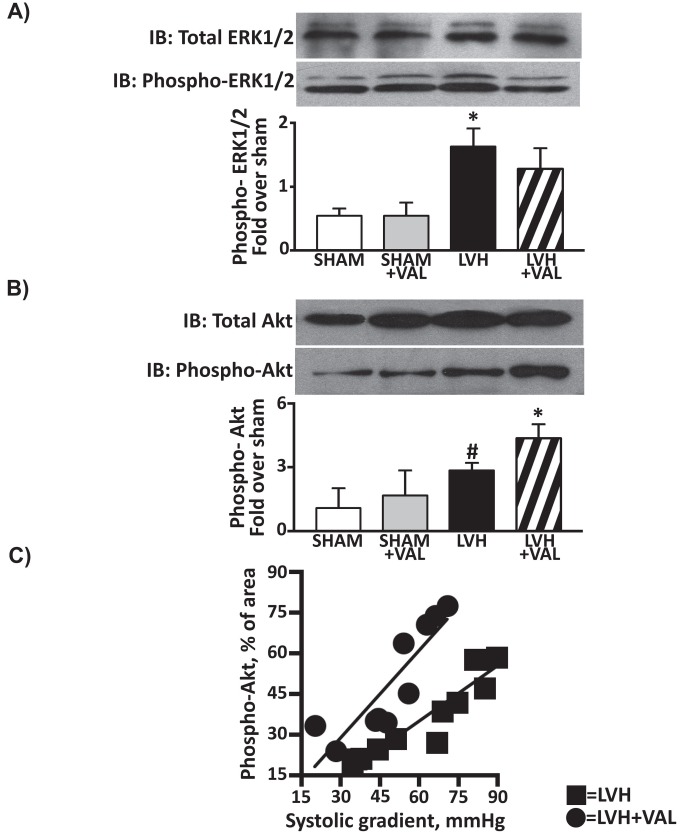
The maladaptive and detrimental molecular activation in hypertrophic hearts is attenuated by AT1R blockade.
A: Increased phosphorylation of MAPK-ERK1/2 was observed in LVH group (1.6 fold over sham) compared to sham groups and to LVH+VAL group (1.3 fold over sham, *p<0.05 vs. all). B: Cardiac levels of activated Akt were significantly higher twelve weeks after aortic banding compared to sham-operated rats (2.8 fold over sham, # p<0.05 vs. SHAM and SHAM+VAL), and were even more increased in hypertrophic group treated with valsartan (4.4 fold over sham, *p<0.05 vs. all). C: Correlation between trans-stenotic systolic supravalvular gradient and activation of Akt in hypertrophied hearts; untreated rats with aortic banding (squares, LVH, N=12) show reduced levels of p-Akt over the entire spectrum of systolic gradients (20.1÷89.6mmHg) compared to hypertrophied rats treated with valsartan (circles, LVH+VAL, N=10).